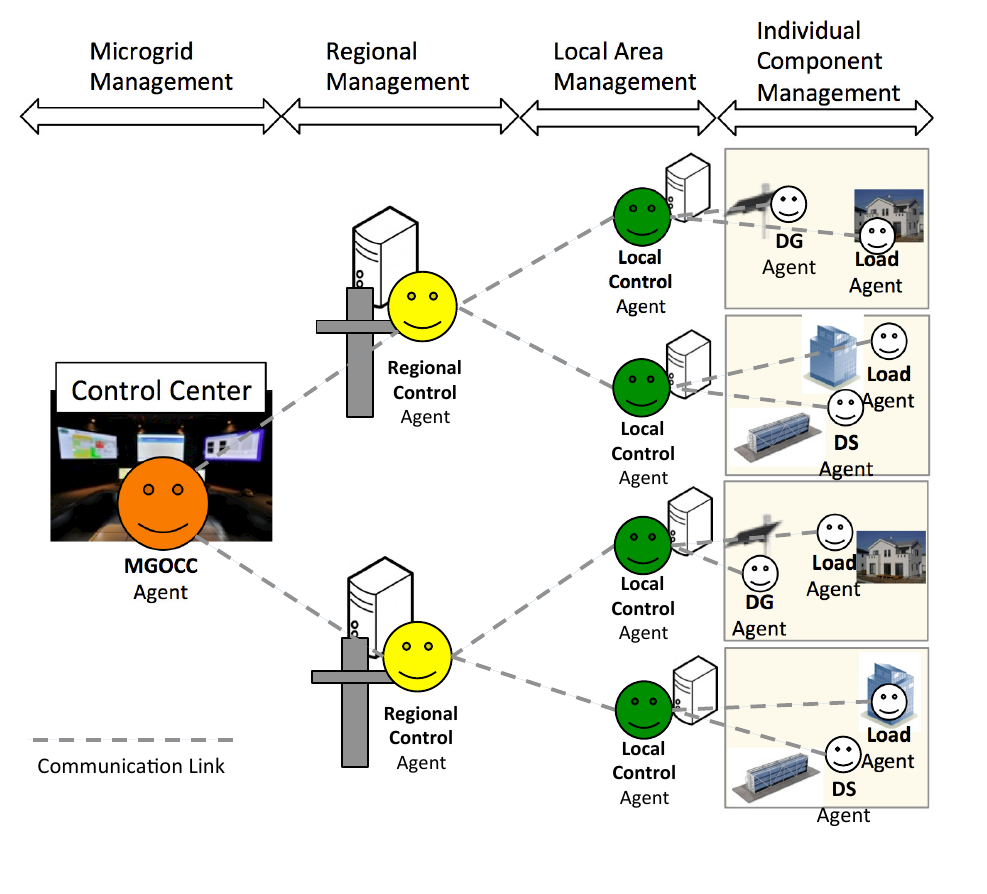
Figure 4. The proposed hierarchical architecture of a multiagent system.